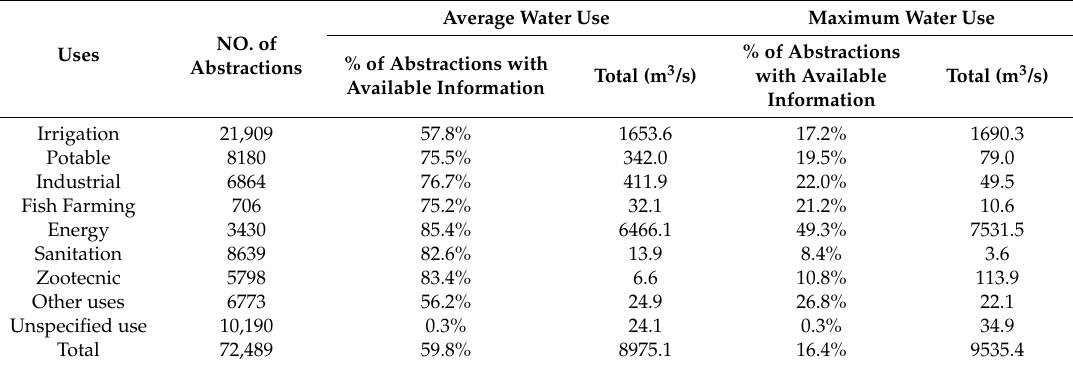
Table 5. WAL Census (source: own elaboration based on WAL data collected from regional authorities